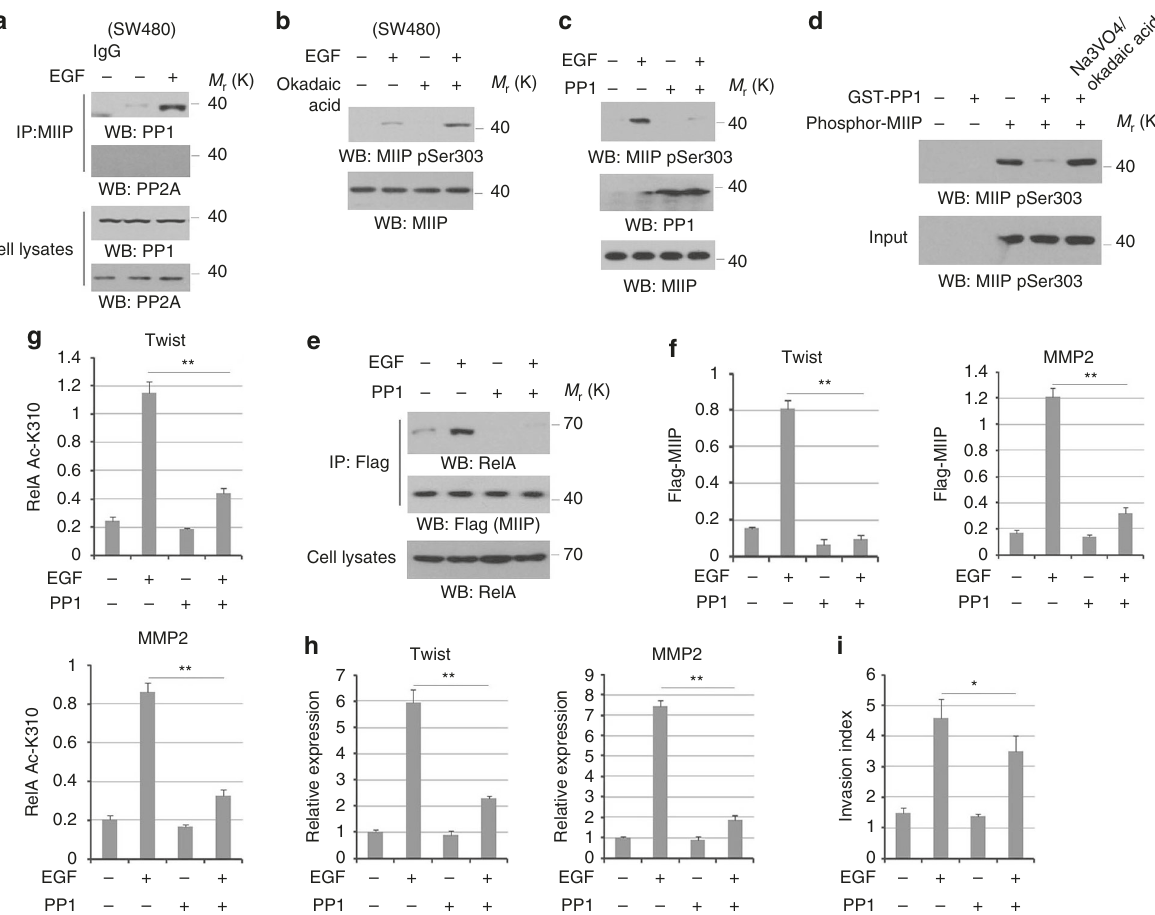
Fig. 3 PP1 mediates MIIP dephosphorylation. a SW480 cells were treated with or without EGF. Cellular extracts subjected to immunoprecipitation with an anti-MIIP. b SW480 cells pretreated with Okadaic acid (a PP1 and PP2A inhibitor) (30 nM) were stimulated with or without EGF (100 ng/ml) for 30 min. c HCT116 cells transfected with or without plasmid for expressing PP1 were treated with or without EGF (100 ng/ml) for 30 min. d In vitro dephosphorylation analyses were performed by mixing the puri fi ed active PP1 with PKC ε -phosphorylated GST-MIIP proteins in absence or presence of Na3VO4/Okadaic acid. e – h HCT116 cells expressing Flag-MIIP were transfected with or without plasmid for expressing PP1. Cells were treated with or without EGF (100 ng/ml) for 10 h. Cellular extracts subjected to immunoprecipitation with an anti-MIIP ( e ). ChIP analyses were performed. The primers covering RelA binding site of Twist or MMP2 gene promoter region were used for the q-PCR ( f , g ). Relative mRNA levels were analyzed by q-PCR ( h ). ( i ) HCT116 cells transfected with or without plasmid for expressing PP1 was treated with or without EGF (100 ng/ml). Cell invasion assays were performed. In f , g , ChIP analyses with indicated antibodies were performed. The primers covering RelA binding site of MMP2 gene promoter region were used for the q-PCR. The Y axis shows the value normalized to the input. In a – e , immunoblotting analyses were performed using the indicated antibodies. In a – e , immunoblotting analyses were performed using the indicated antibodies and data represent one out of three experiments. In g , f – i , the values are presented as mean ± s.e.m. ( n = 3 independent experiments), * represents P < 0.05 and ** represents P < 0.01 (Student ’ s t -test) between the indicated analyses showing that the interaction between RelA and MIIP (Fig. 3e), as well as the accumulation of MIIP (Fig. 3f) and RelA K310 acetylation (Fig. 3g) at promoter regions of MMP2 and Twist were disrupted in HCT116 cells with overexpression of PP1. Accordingly, transcriptions of MMP2 and Twist were also blocked by PP1 induced by EGF (Fig. 3h). However, transwell analysis showed invasion induced by EGF was attenuated by overexpression of PP1 in HCT116 cells to a lesser extent compared with that effect from MIIP S303A (Fig. 3i), suggesting the additional function of PP1 is implicated in tumor cell invasion. In contrast, PP1 depletion in SW480 cells (Supplemen- tary Fig. 3c) promoted EGF-induced MIIP-S303 phosphorylation